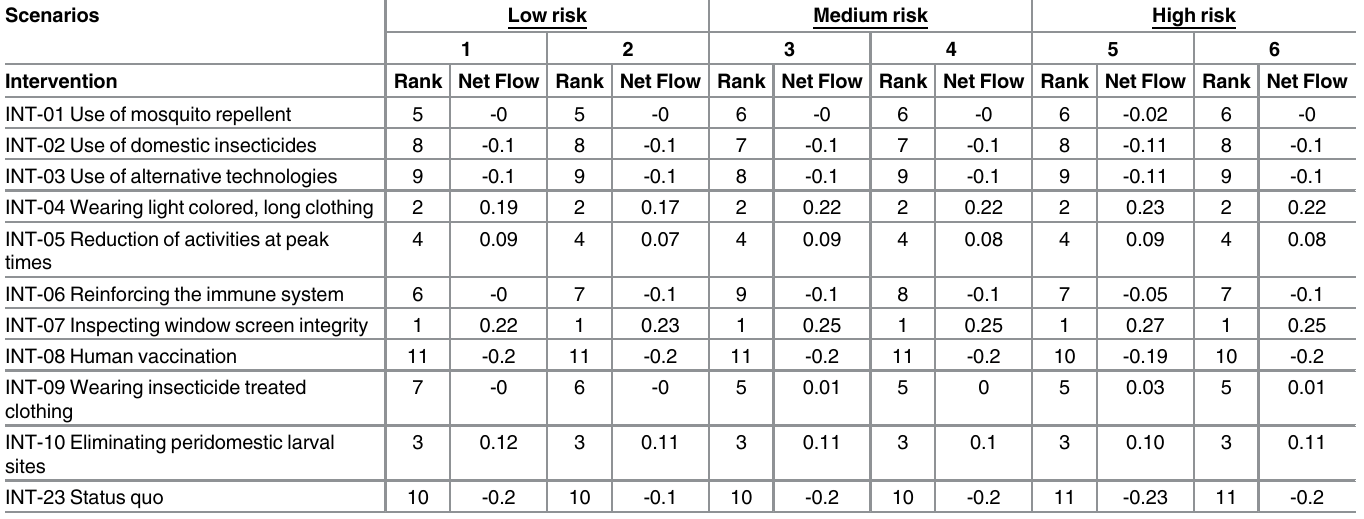
Table 4. Ranking of the individual-level protection